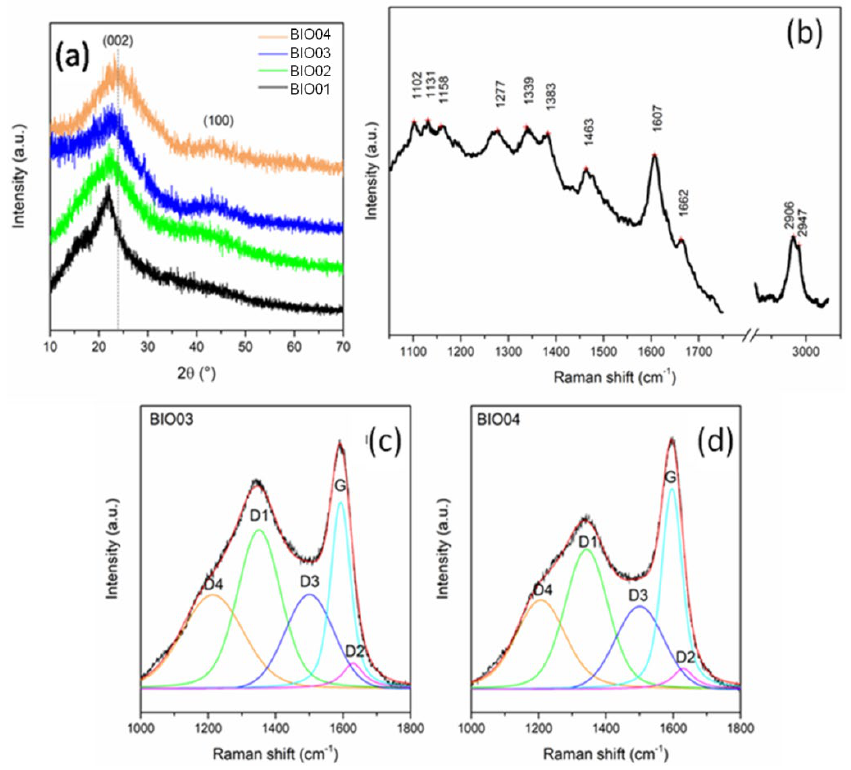
Figure 3. ( a ) Normalized XRD pattern of BIO01, BIO02, BIO03, and BIO04; ( b ) Raman spectra of BIO01; and curve-fitted Raman spectra of ( c ) BIO03 and ( d ) BIO04. Biomass-derived materials constituted by cellulose, lignin and hemicellulose are poorly detectable by XRD due to their amorphous state [30,31]. In the pyrolyzed samples BIO03-BIO04,2 broad reflections typical of amorphous carbons with nanocrystalline domains at about 2 θ = 23 ◦ and 43 ◦ can be observed: both are related to a graphite-like structural arrangement. In particular, the first peak is related to (002) interlayer reflection of stacked aromatic layers, whereas the second peak is due to in-layer (100) reflection [5,11,25]. Overall, as expected, pyrolysis drives an evolution of the biomass to a poorly graphi- tized material. BIO04 pattern shows (002) peak at larger diffraction angles, thus